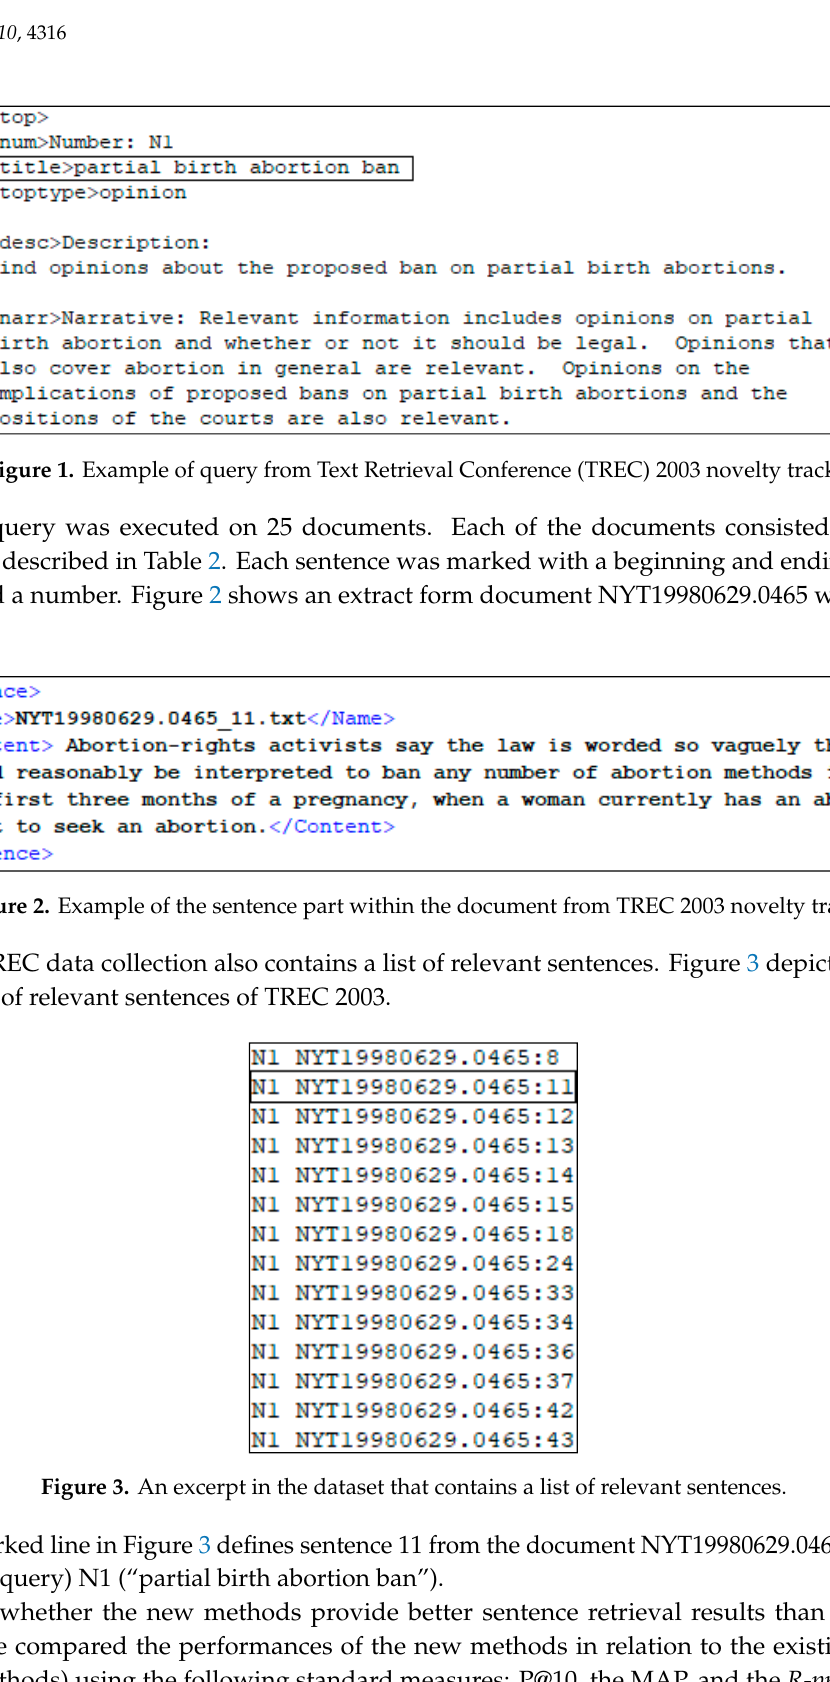
Figure 3. An excerpt in the dataset that contains a list of relevant sentences.